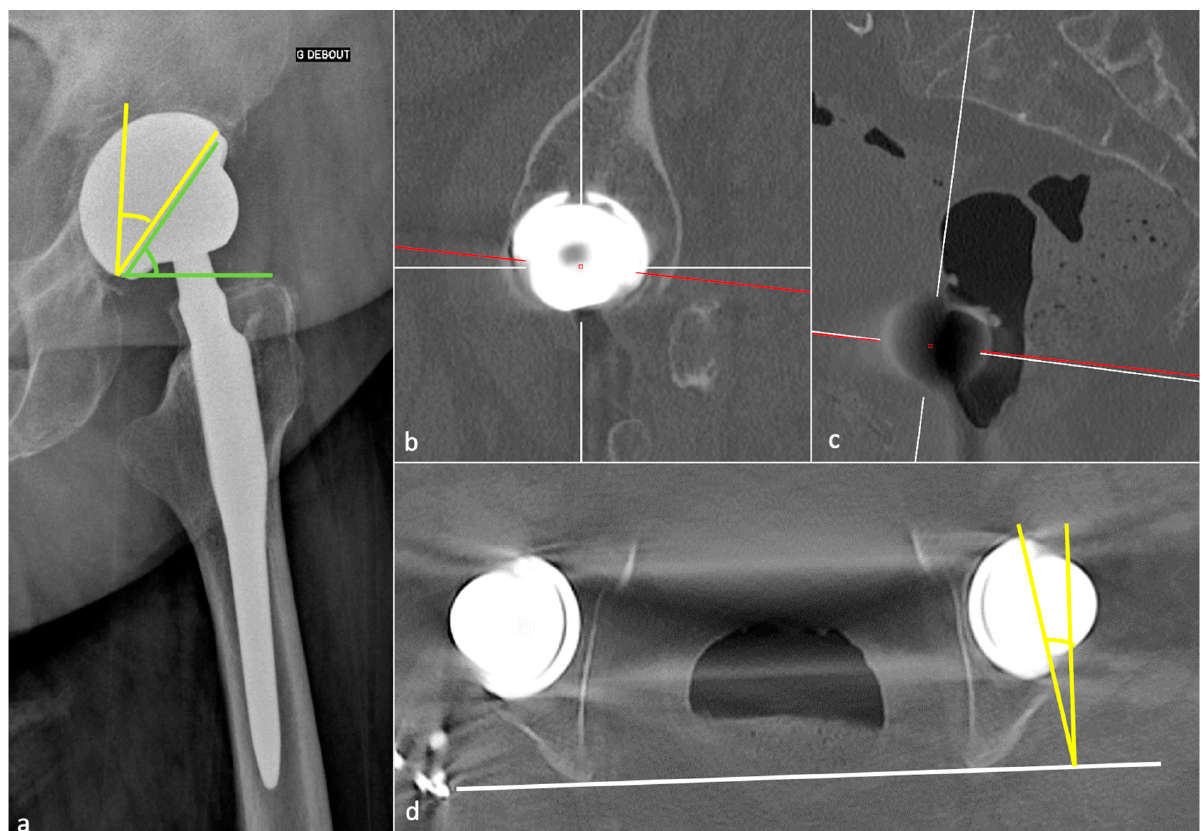
Figure 8. Acetabular cup anteversion and sagittal inclination. The radiographic angle of antever- sion is shown on ( a ) a hip profile radiograph and corresponds to the angle between the vertical axis and the acetabular piece edges (yellow angle). The sagittal acetabular inclination is shown in ( a ) and corresponds to the angle between the horizontal axis and the acetabular piece edges (green angle). A CT method is then proposed to calculate anteversion: on ( b ) a sagittal CT slice, one should restore the femoral head center, then align it within the middle of S1 superior plate as shown on ( c ) in the sagittal plane. The anteversion can be measured in the so-created plane (red lines) on ( d ), as the yellow angle between the cup edges and the perpendicular line to the transischiatic line (white line).